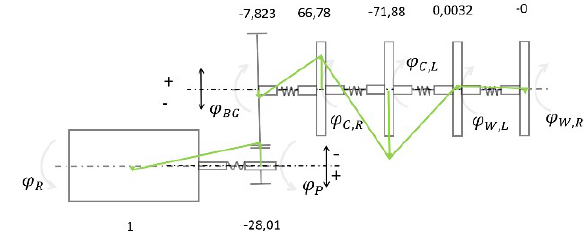
Figure 15. Sixth natural mode of torsion oscilla- tions [3].